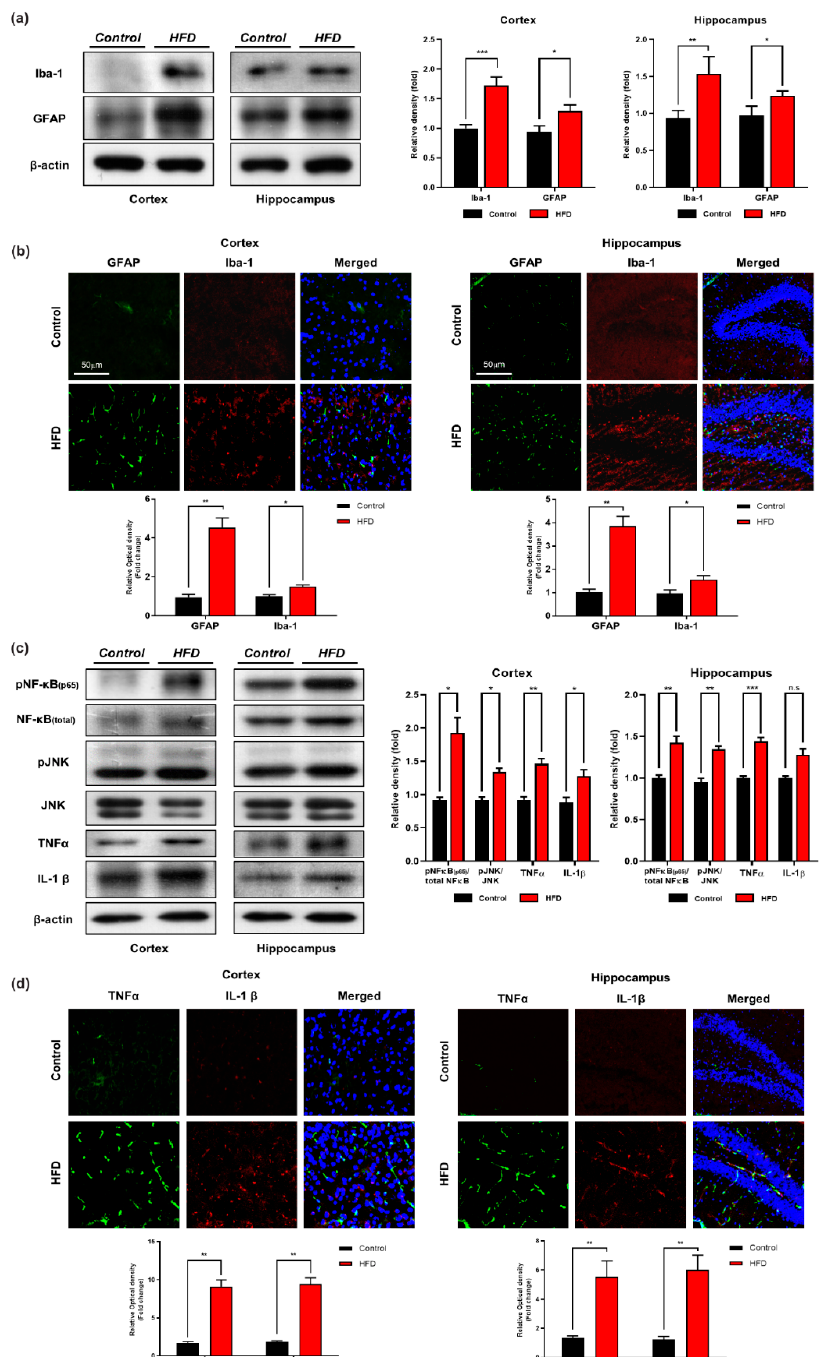
Figure 4. HFD increased level of activated microglia, astrocytes, neuroinflammatory markers and stress kinase -c-Jun N-terminal kinase (JNK)levels in HFD mouse brain. ( a ) Immunoblot result of ionized calcium binding adaptor molecule (Iba-1) and glial fibrillary acidic proteins (GFAP) in cortex and hippocampus ( b ) Immunofluorescence Imaging of Iba-1 and GFAP in cortex and hippocampus ( c ) Western blot result of tumor necrosis factor-alpha (TNF α ), nuclear factor kappa B (NFkB), JNK and interleukin 1 β eta (IL-1 β ) in cortex and hippocampus ( d ) Confocal imaging with TNF α and IL-1 β in the cortex and hippocampus of control and HFD group. Data are presented as mean ± SEM. Data for immunofluorescence and western experiment are compared using the Students t -test and other data are compared using one-way ANOVAs. Data are compared using U = the unpaired Students t -test. Significance = * p < 0.05, ** p < 0.01, *** p < 0.001. n.s = non-Significance.